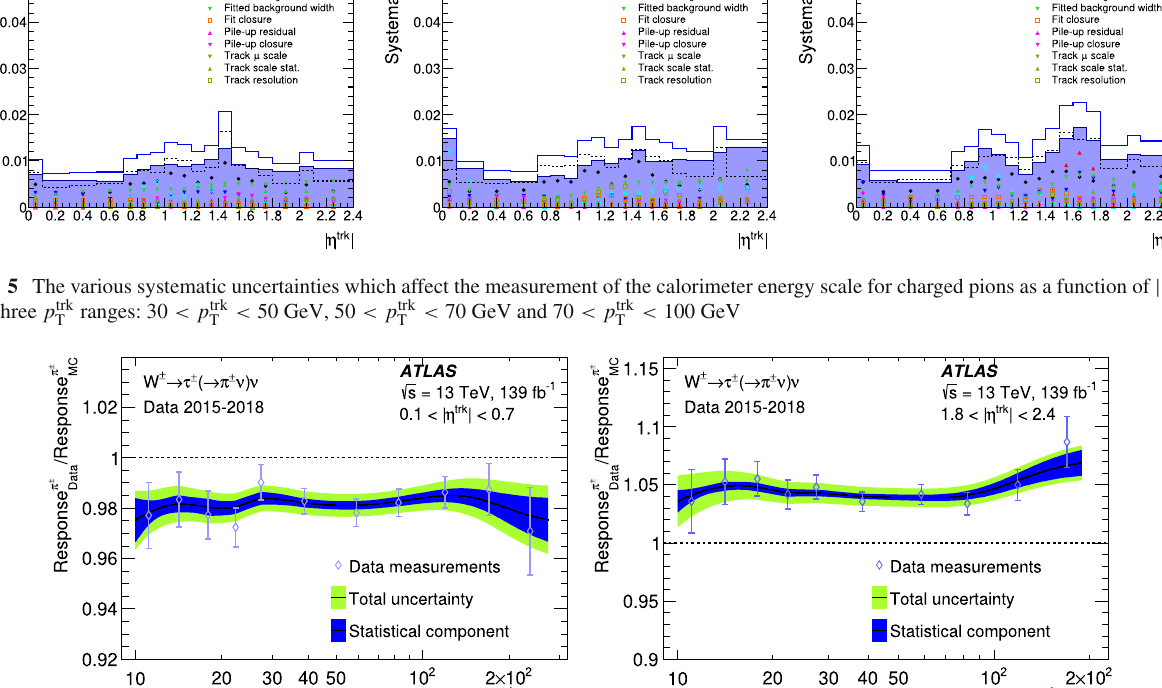
Fig. 6 The measured data to simulation ratio of the response as a func- tion of p trk for the barrel (left) and endcaps (right). Points represent the T different measurement bins with their total uncertainty from both the